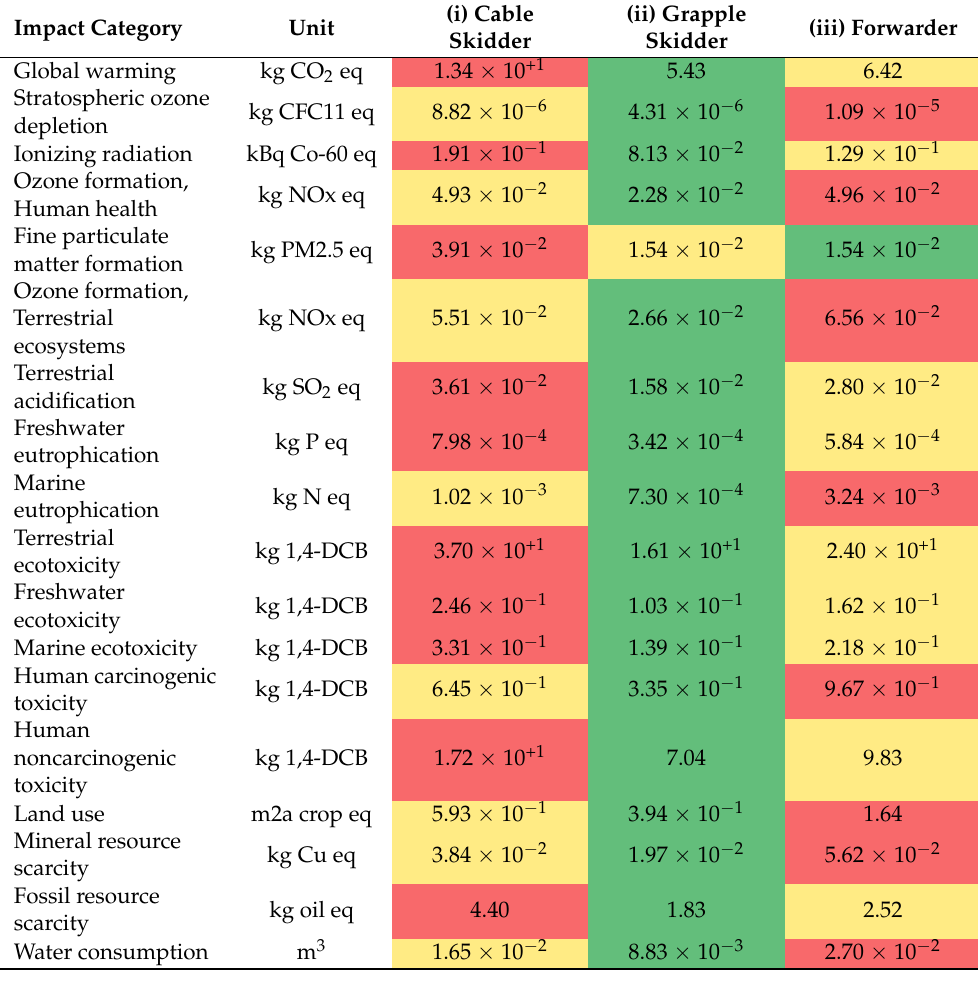
Table 6. Characterisation of the impacts of different logging scenarios per “1 m 3 of wood harvested”. Impact Category Unit